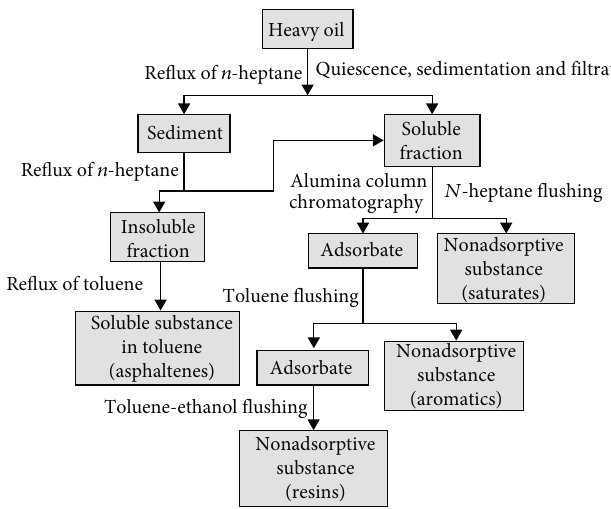
Figure 3: Flow chart of the four-component determination of heavy